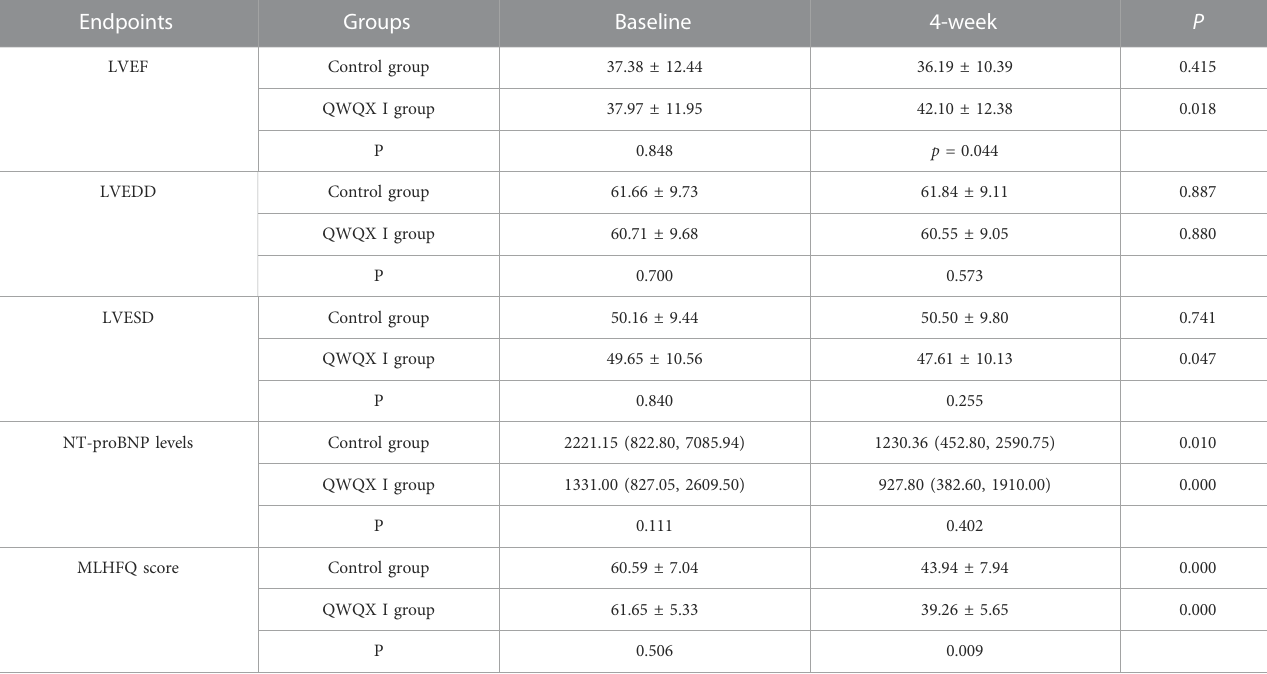
TABLE 2 Change in endpoints from baseline to after 4 weeks of follow-up.